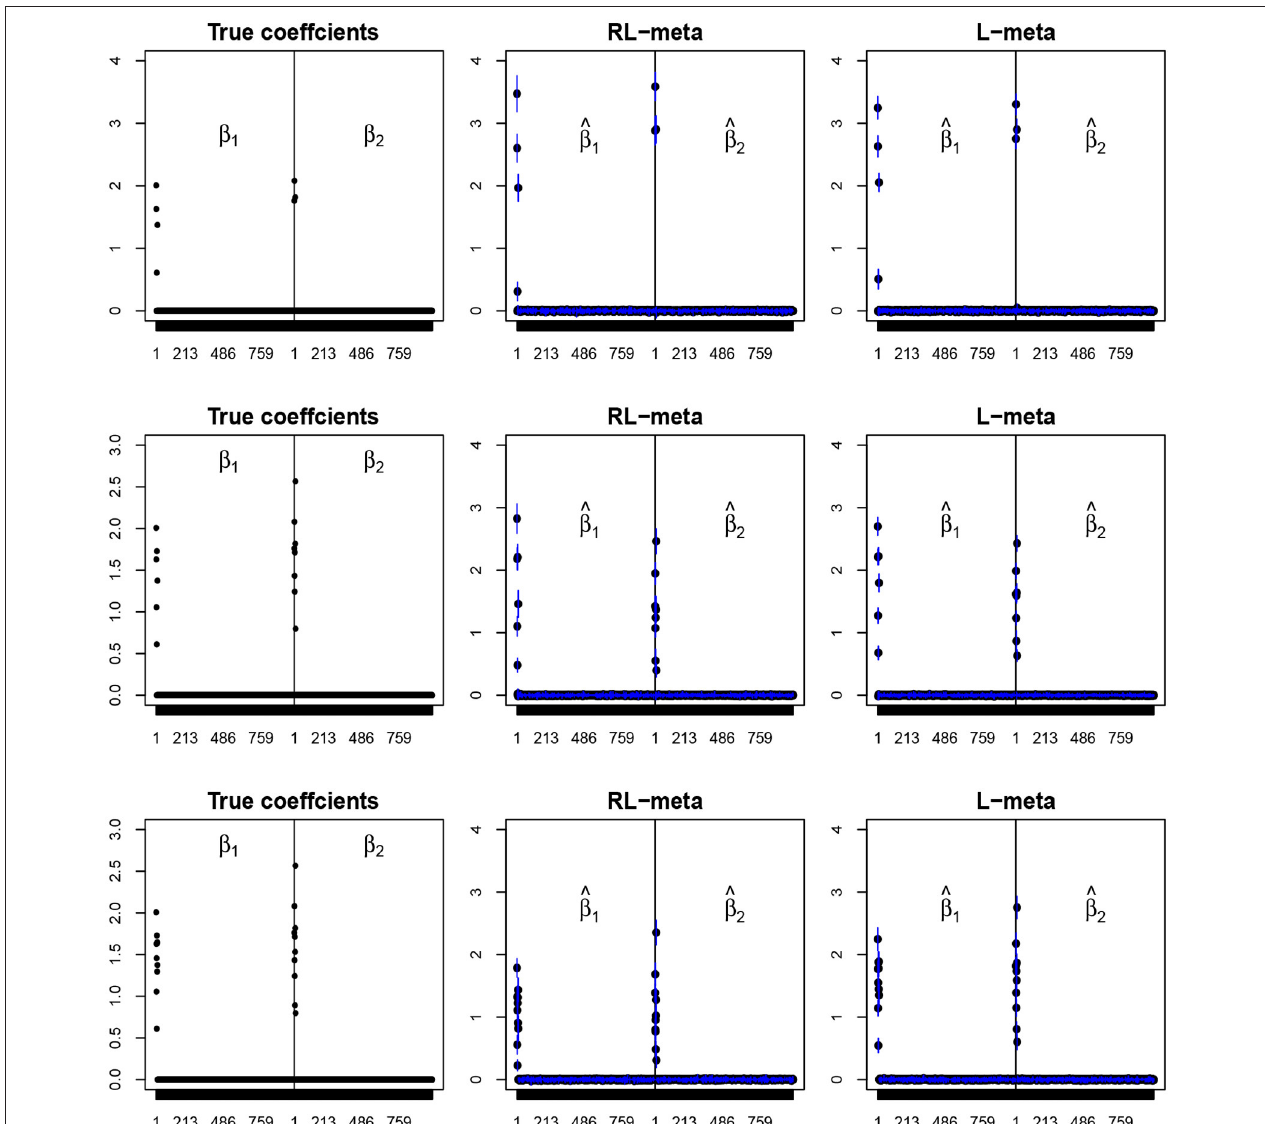
FIGURE 3 | The coefficient estimates with clean data for M = 2 and ( n , p ) = (150,1,000). The blue points and lines represent the estimated values and the interval estimates of coefficients over 100 simulations. Rows from top to bottom correspond to π = 0.2,0.5,0.9,